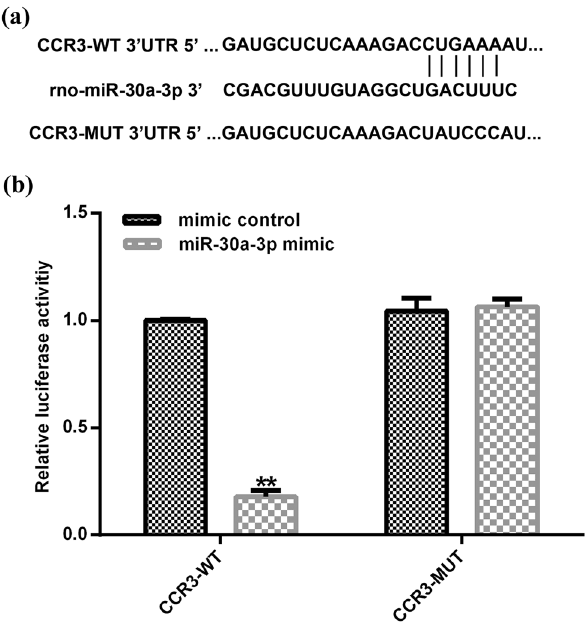
Figure 2: CCR3 is a target gene of miR - 30a - 3p. ( a ) The interaction between miR - 30a - 3p and 3 ′ - UTR of CCR3 was predicted using a microRNA target site prediction software. ( b ) The direct targeting of miR - 30a - 3p to the 3 ′ - UTR of CCR3 was veri fi ed using a dual - luciferase reporter assay. CCR3, CC chemokine receptor 3; 3 ′ -